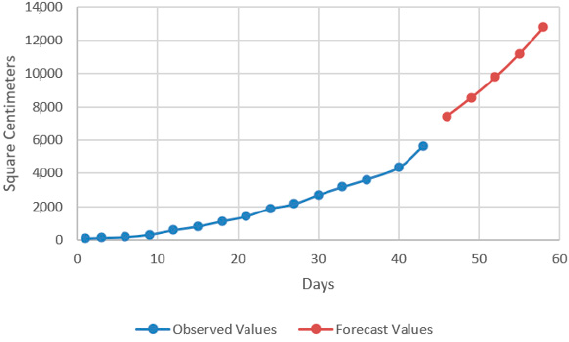
Figure 13. The evolution of basil leaves area in AH experimental variant.